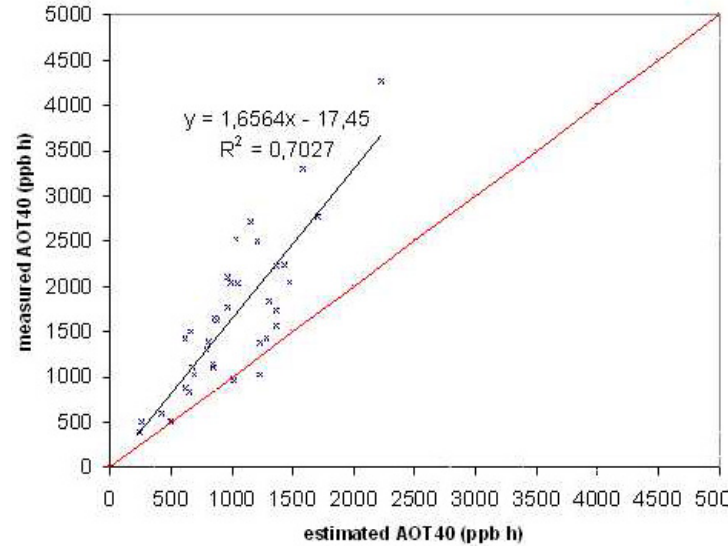
FIGURE 8. Measured vs. estimated AOT40 data (corrected as in Fig.